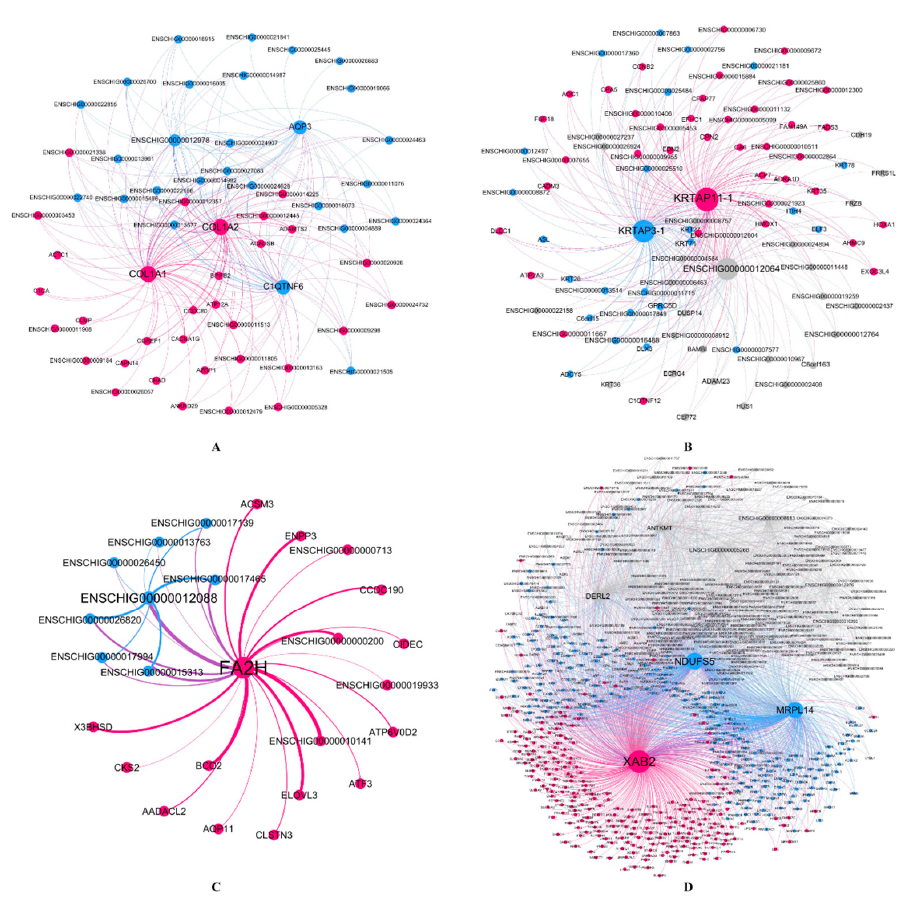
Figure 6. Visualization of coexpression network between hub genes with interaction genes in four stages. ( A ) anagen, ( B ) catagen, ( C ) telogen and ( D ) late-telogen. The size of the circle represents the degree values of the adjacency genes in the network from WGCNA. Nodes and edges were colored based on Gephi modularity class to classify individual nodes into network communities. The thickness of the edge represents the strength of the interaction between genes, and the thicker the line, the stronger the interaction.